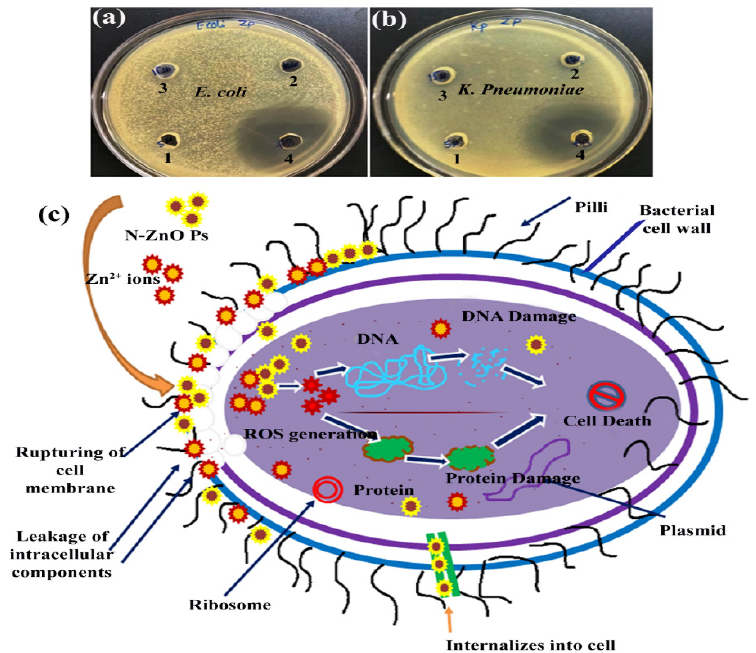
Figure 8. ( a , b ) Antibacterial activity of N-ZnO Ps against ( a ) E. coli and ( b ) K. pneumoniae , and ( c ) the possible antibacterial activity mechanism. possible antibacterial activity Table 1. Antibacterial activity of N-ZnO Ps.